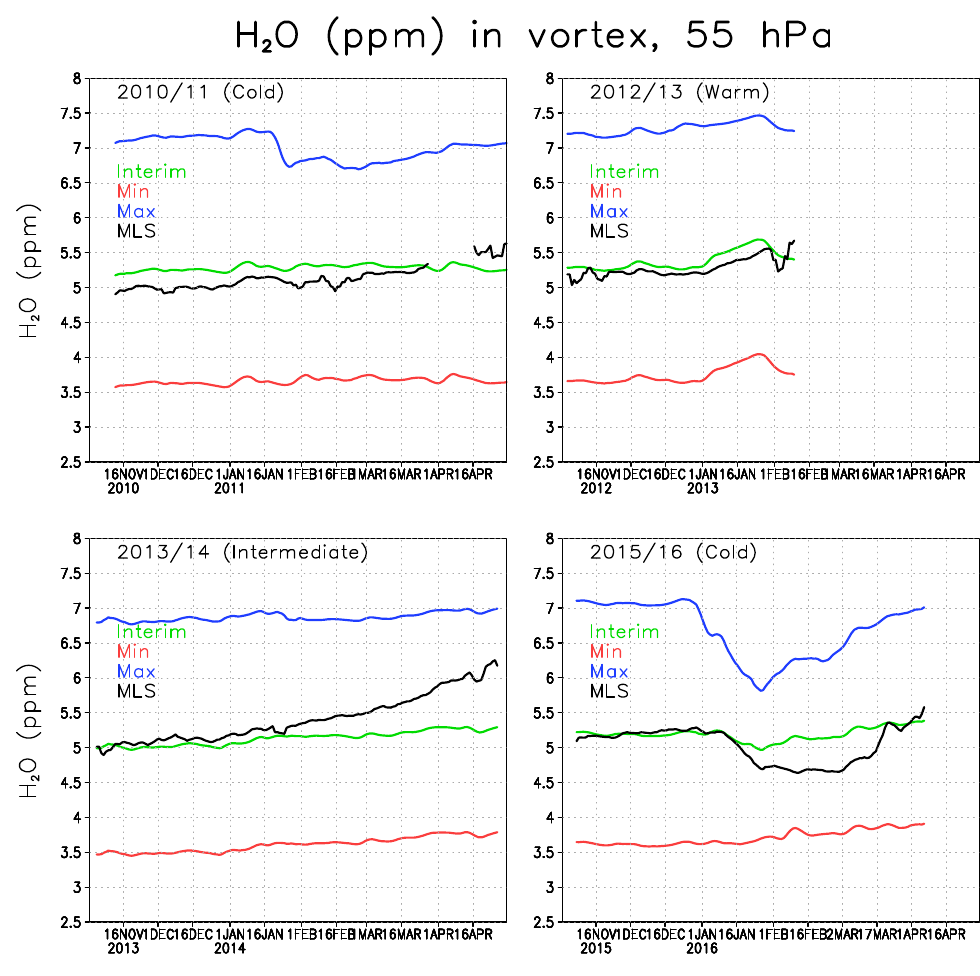
Figure 3. Water vapour concentration (ppmv) at 55hPa within the Arctic polar vortex. The green line denotes the Interim simulation, blue denotes the Max simulation, red denotes the Min simulation and black denotes the